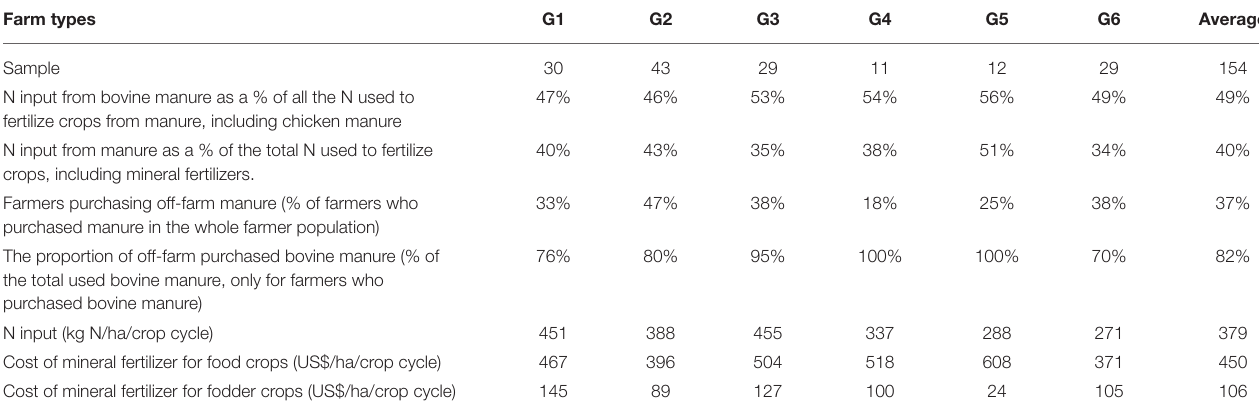
TABLE 2 | Fertilization management at the farm level, without inputs from leased grazing (154 farms). Farm types G1 G2 Sample